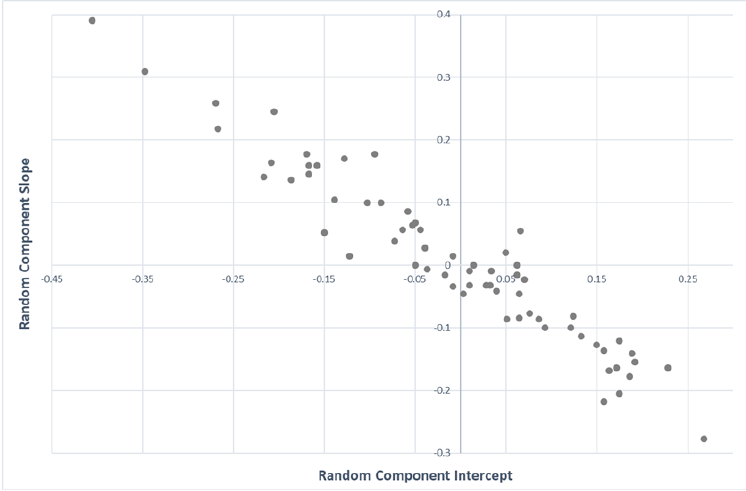
Figure 4. Relationship between random neighbourhood effects of slope and intercept. Neighbourhoods with a negative intercept (i.e., lower consumption than the mean for P = 0) tended to have positive slope components, which tended to have lower elasticities. Thus, consumption differences between neighbourhoods were not independent of price.